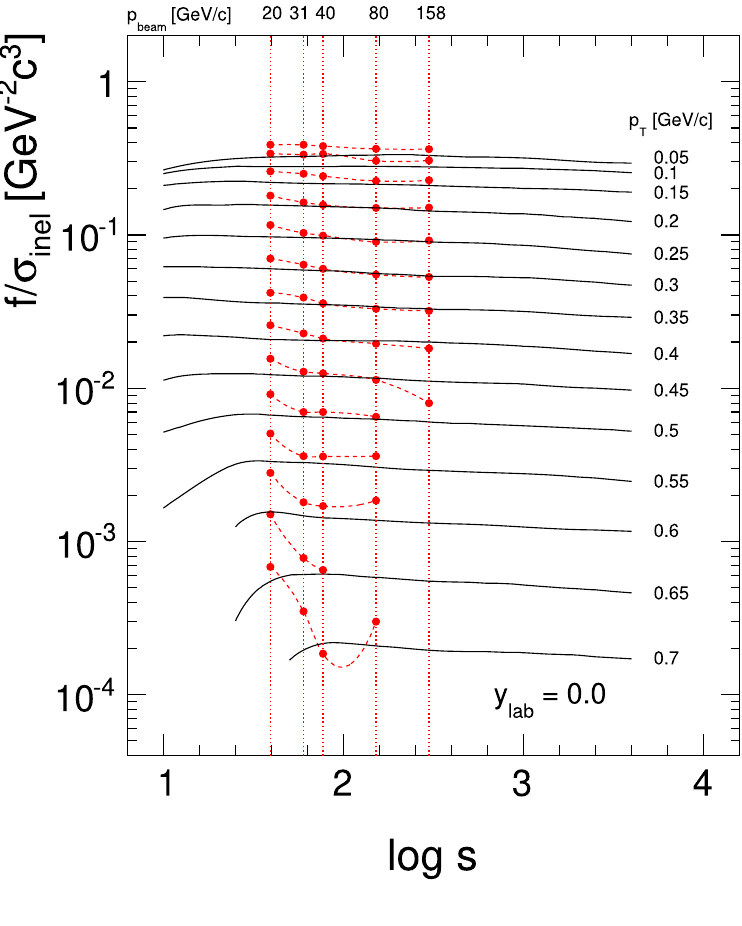
cation of the momentum scale starting from the global interpolation, as a function of y lab at fixed p T , for p beam = 31 GeV/c